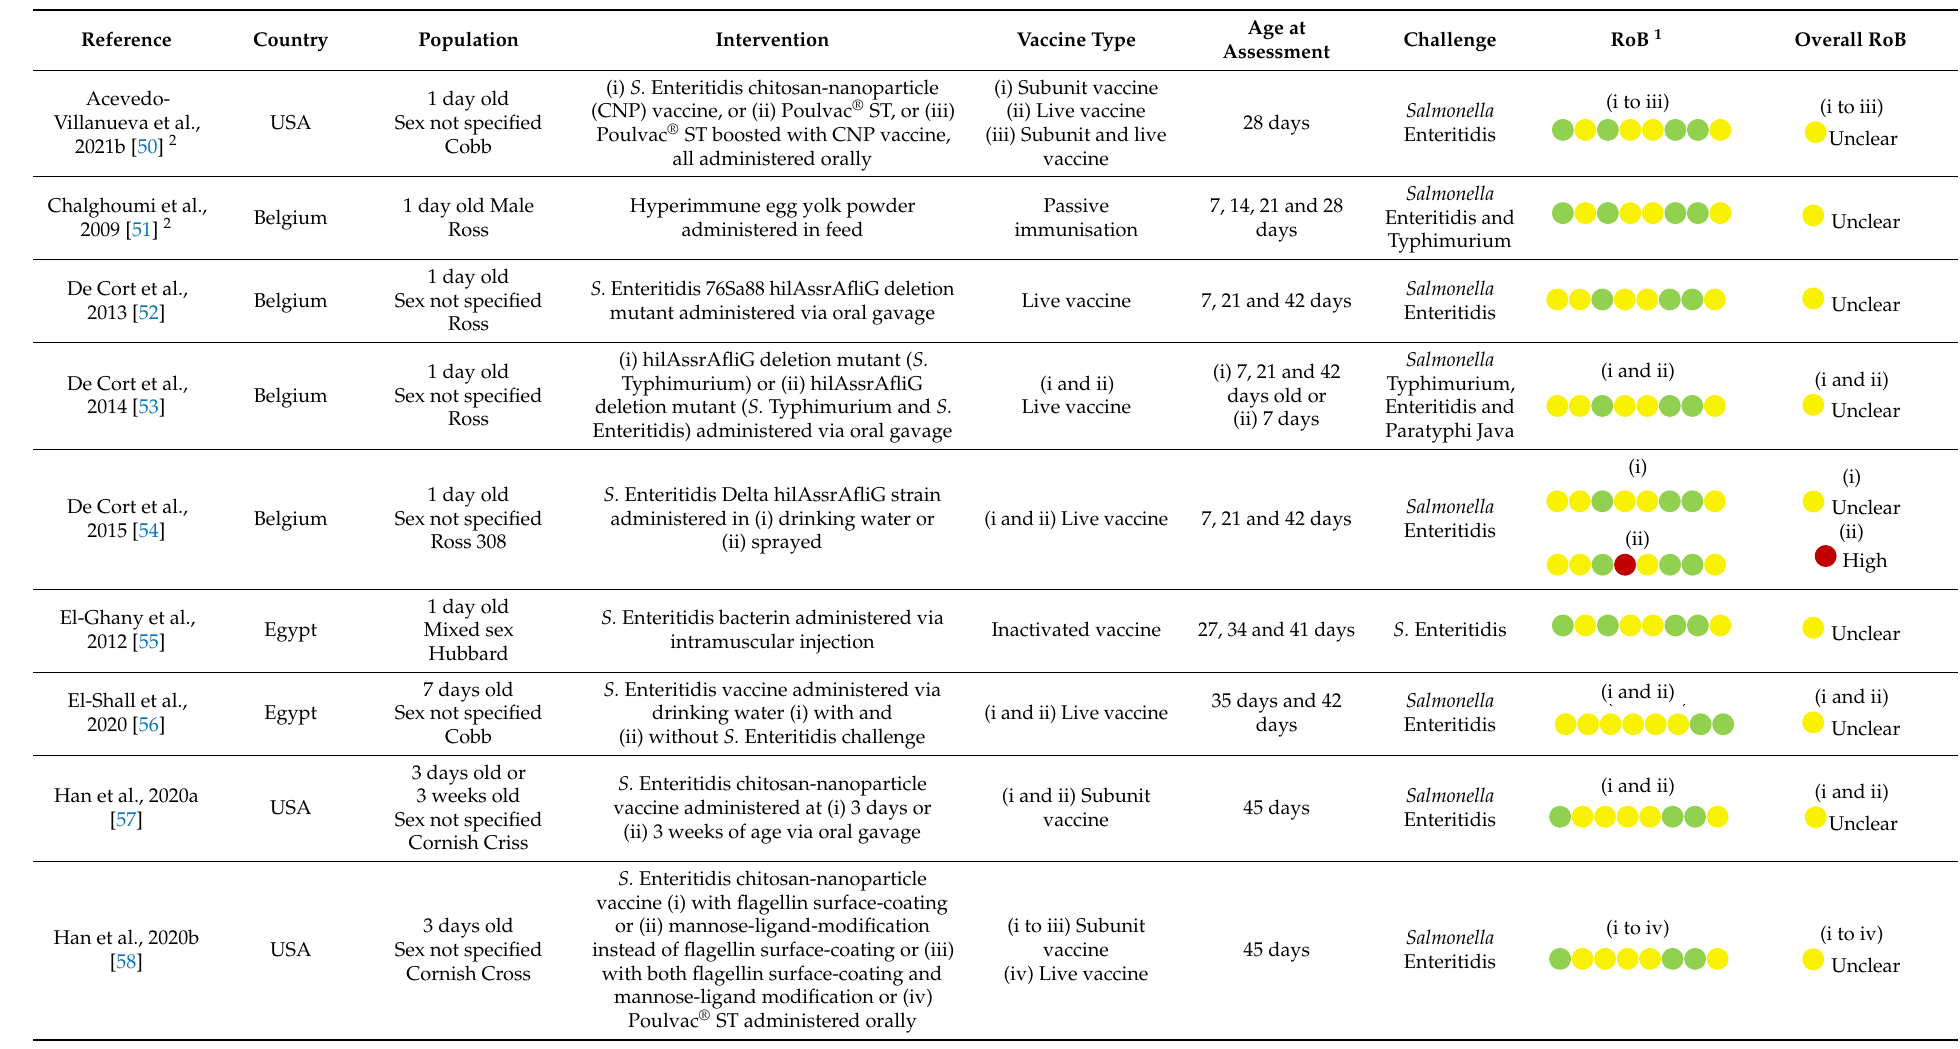
Table 2. Summary of key characteristics of studies that investigated the effects of Campylobacter vaccines on caeca Campylobacter.